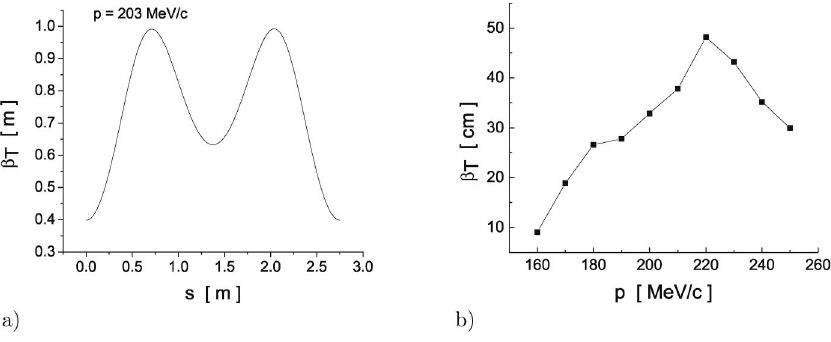
FIG. 7. (a) Beta function vs position in the cell; (b) beta function vs muon momentum at the center of the